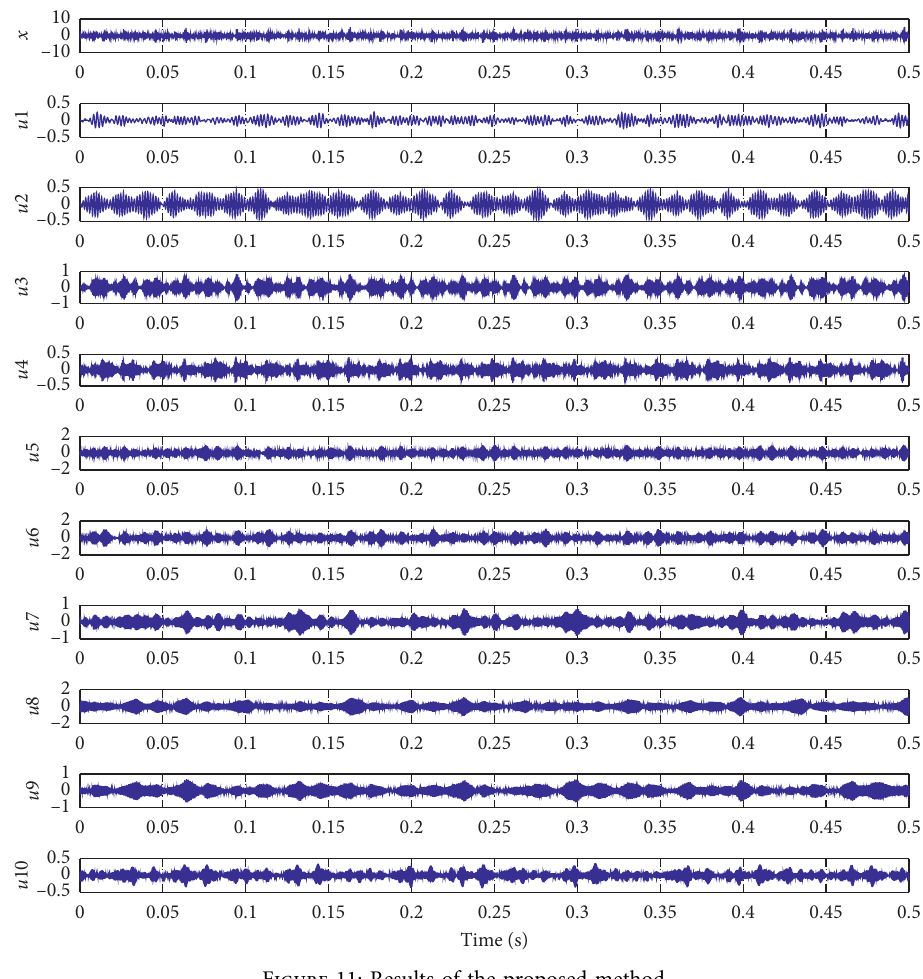
Figure 11: Results of the proposed method.